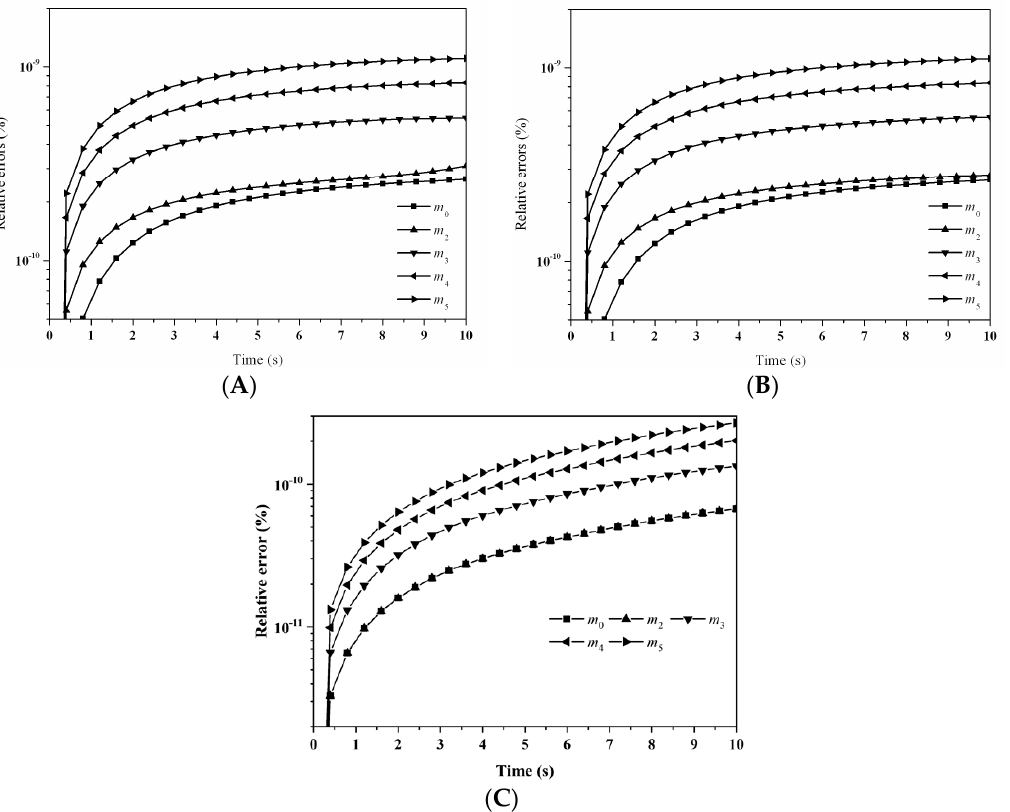
Figure 3. Evolution of the relative errors for the first six moments with: ( A ) LFPQMOM; ( B ) QMOM; and ( C ) FPQMOM (square: m 0 ; up triangle: m 2 ; down triangle: m 3 ; left triangle: m 4 ; right triangle: m 5 ).